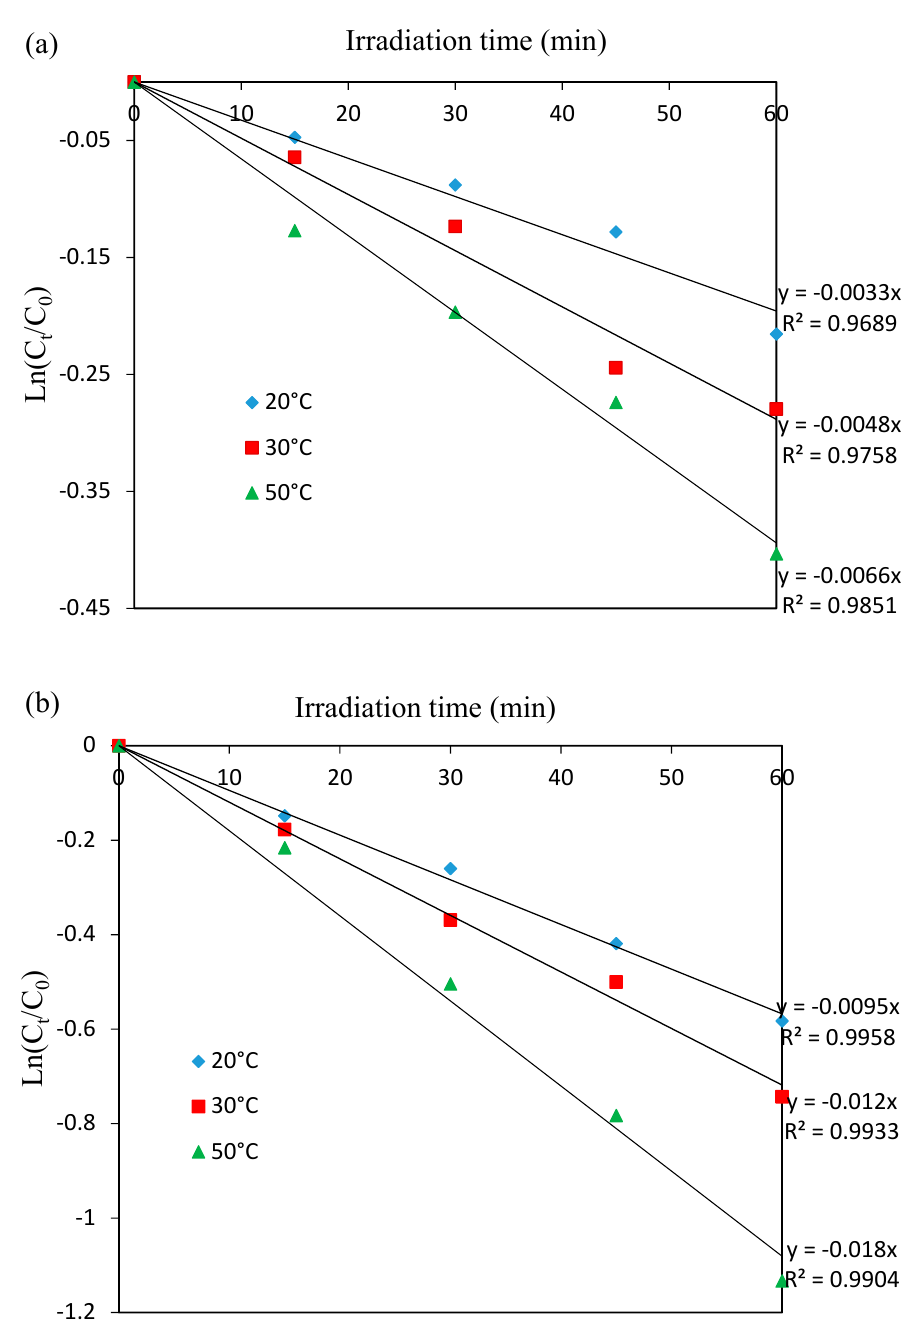
Figure 10. Effect of temperature on the photo-Fenton degradation of 4-CP using: ( a ) M 1 ; and ( b ) M 2 .